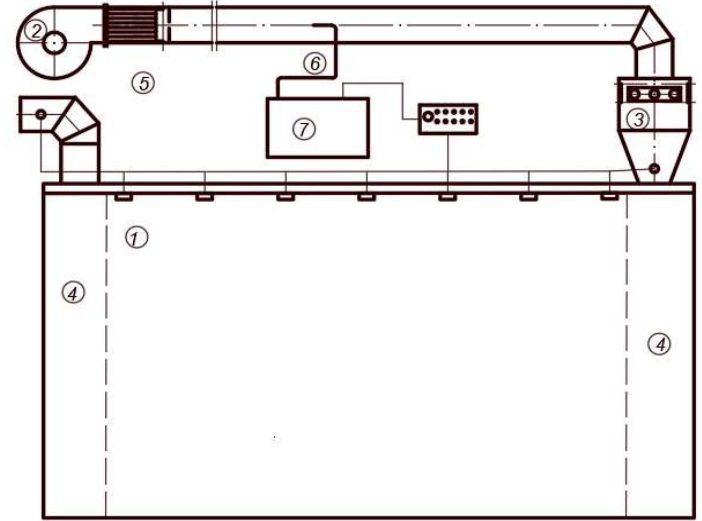
Figure 1. Test stand: 1—rock bed, 2—fan, 3—heater, 4—settling chambers, 5—elements stabilizing flow, 6—anemometer, 7—computer.